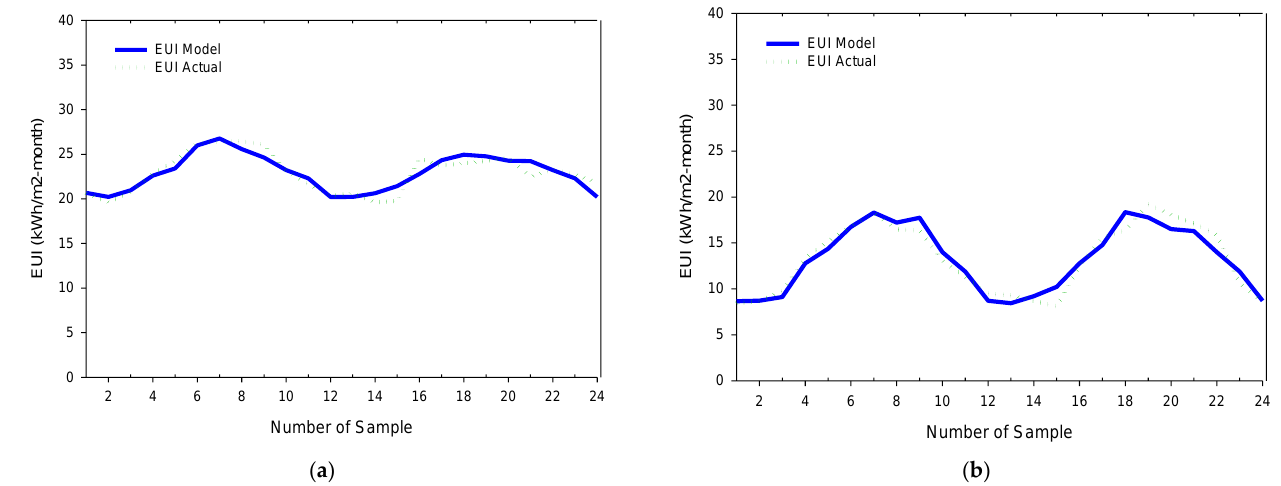
Figure 7. Comparison of EUI baseline model and actual: ( a ) public area and ( b ) guest area.